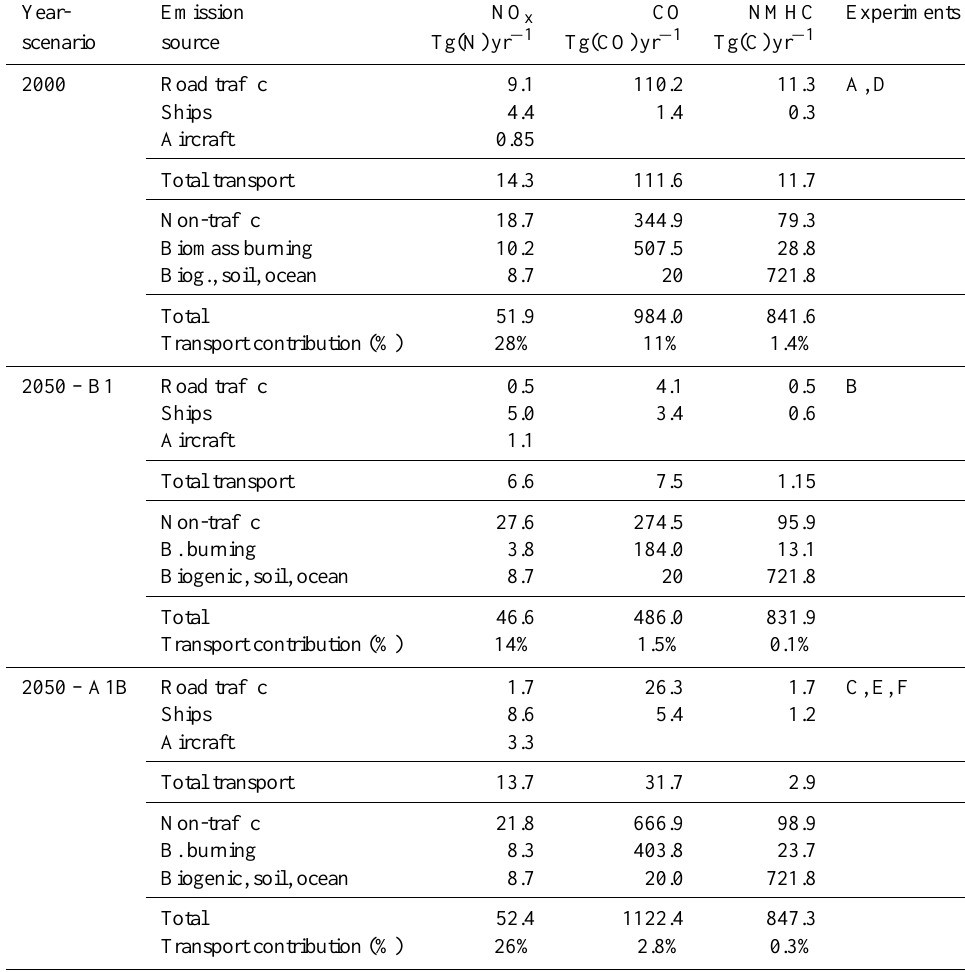
Table 1. Global emissions and corresponding modelling